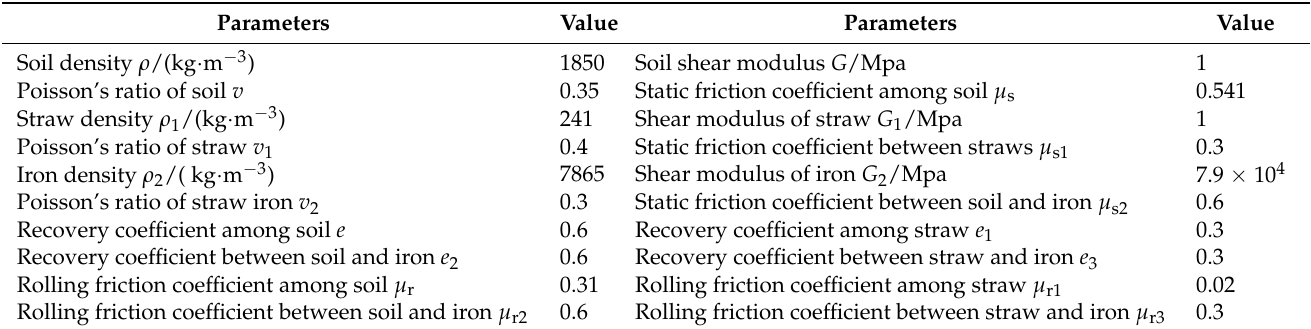
Table 1. Parameter settings for EDEM